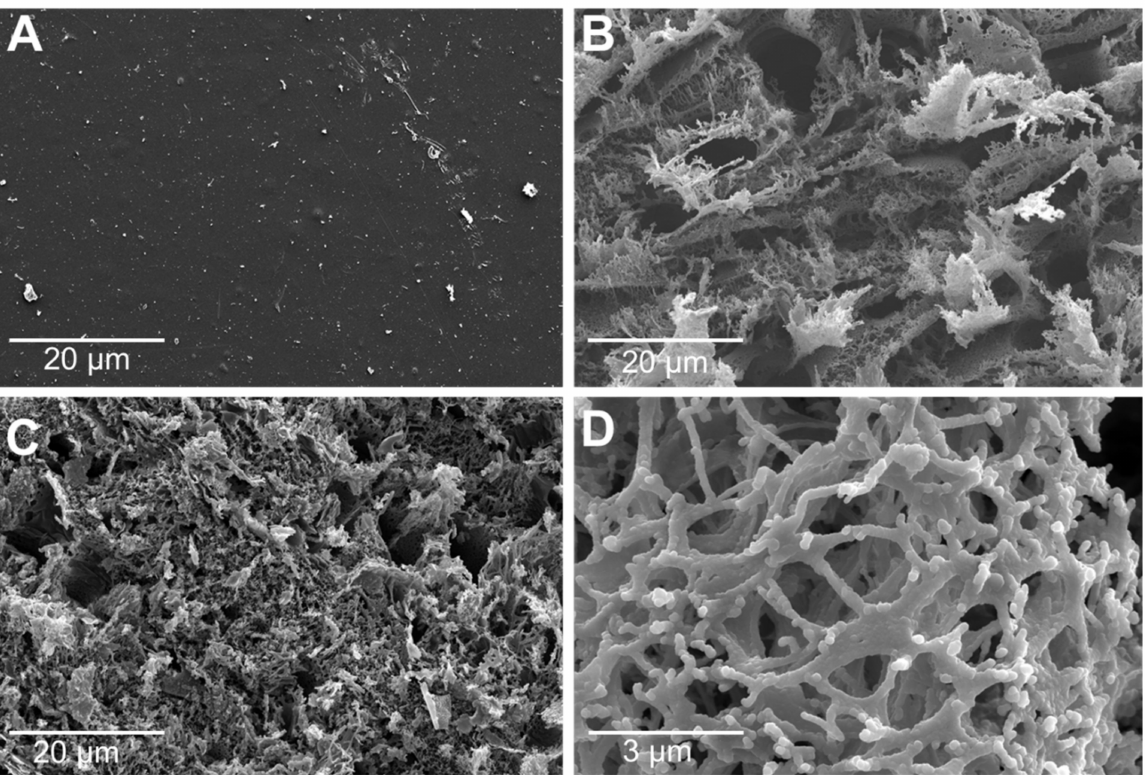
Figure 3. SEM images at 5 kV extraction and acceleration voltage, and at 7.2 mm working distance with scale bar of 20 µ m, for ( A ) bare PI, ( B ) LIG electrode fabricated with 10 cm/s speed and 4.5 W power, and ( C ) LIG electrode fabricated with 10 cm/s speed and 8.6 W power. ( D ) High resolution at 3 µ m showing the graphite